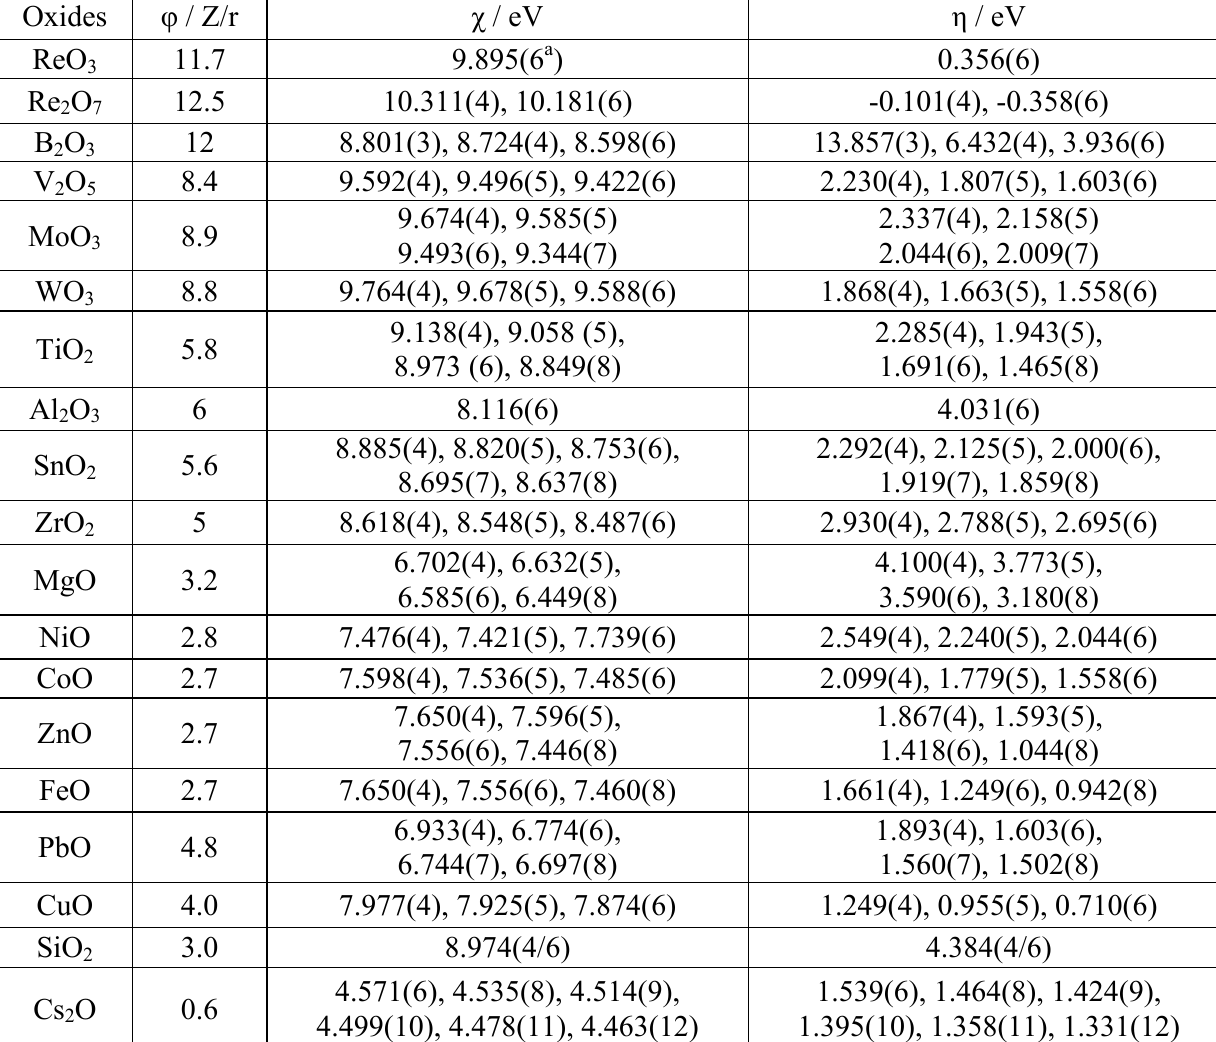
Table 2. Quantum chemistry parameters of solid oxides